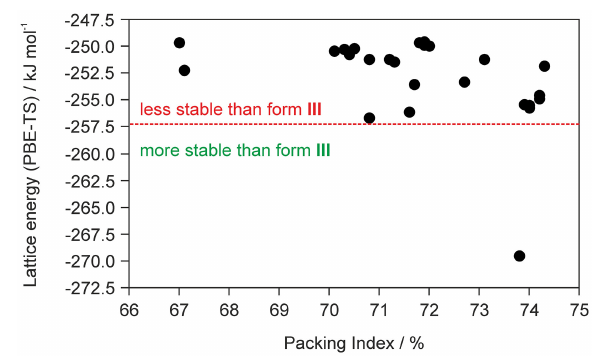
FIGURE 2 | Summary of crystal structure prediction for DDS monohydrate (Z ′ = 1), with each symbol denoting a crystal structure by its lattice energy and packing index. The vertical red dotted line separates the monohydrate structure that was calculated to be more stable than form III and ice from other computed hydrate structures that are less stable.